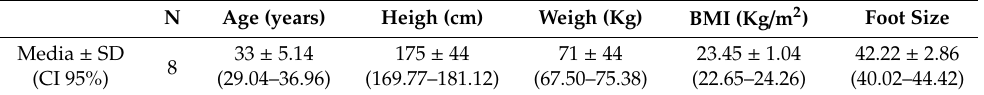
Table 1. Sociodemographic